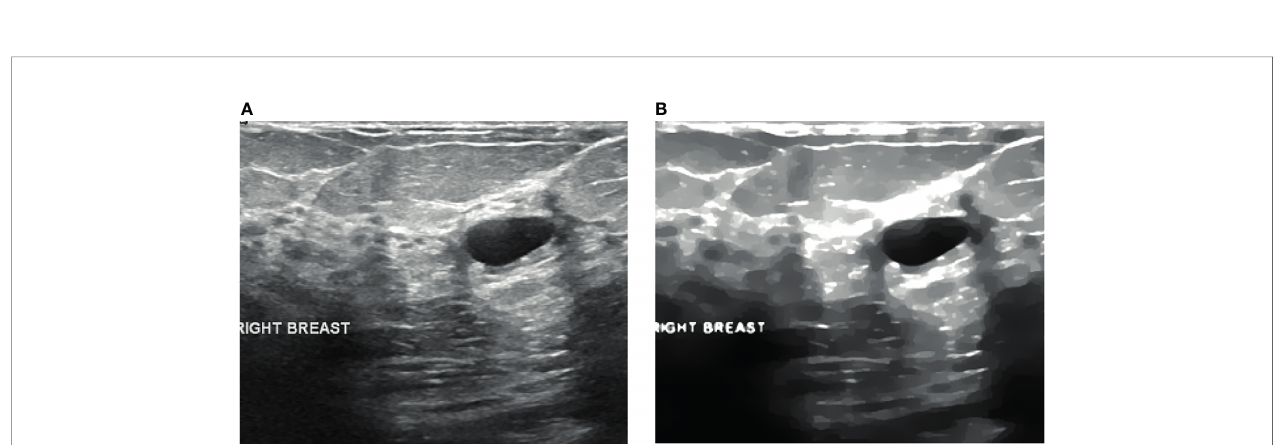
FIGURE 3 | Despeckling results. (A) Raw US image and (B) fi ltered